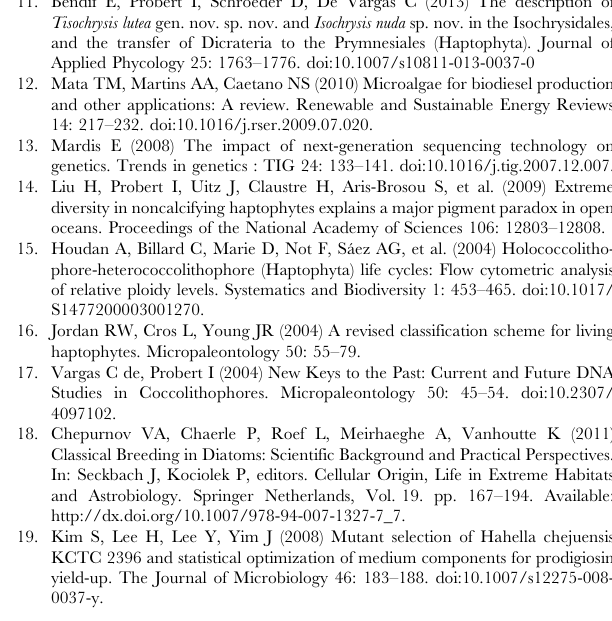
Figure S3 Codon bias analysis. Figure 3A shows codon bias of Tiso and 3B shows comparison of codon bias between reference microalgae. The tree was built using a correlation score matrix of codon bias between microalgae with the hierarchical clustering method WPGMA. Color code: green for chlorophytes, red for rhodophyte, orange for glaucophyte, blue for dinoflagellate, yellow for diatoms and purple for haptophytes. (TIF) Figure S4 Distribution of positional polymorphisms (SNPs and indels) between Tiso-Wt and Tiso-S2M2 per transcripts. Figure S5 Growth of Tiso strains and lipid accumula- tion. Cells were counted with a Malassez counting cell and image analysis (SAMBA software). Lipid accumulation was estimated by measurement of Nile Red fluorescence by spectrofluorimetry as described by Bougaran et al. , [22]. Red color for Tiso-Wt and black color for Tiso-S2M2. The yellow color shows sampling events. Table S1 List of transcripts contained polymorphism identified between Tiso-Wt and